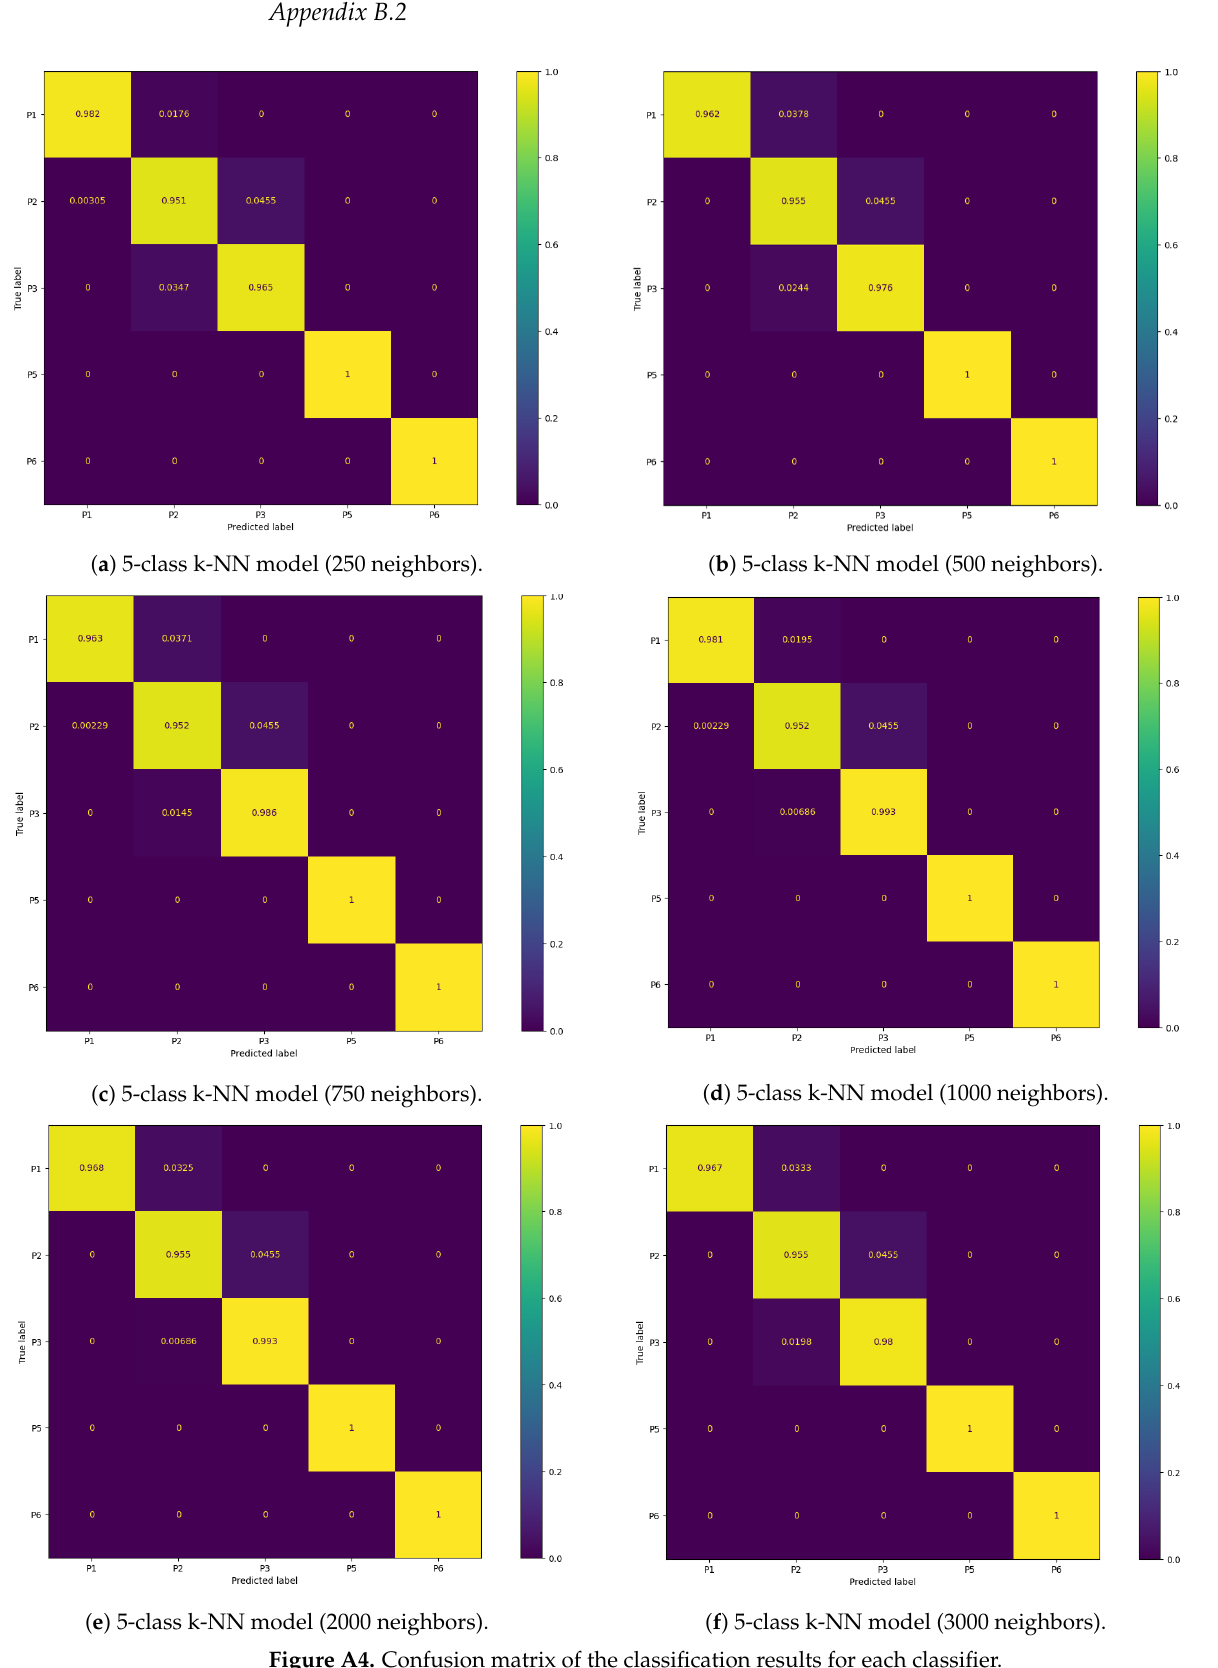
Figure A4. Confusion matrix of the classification results for each